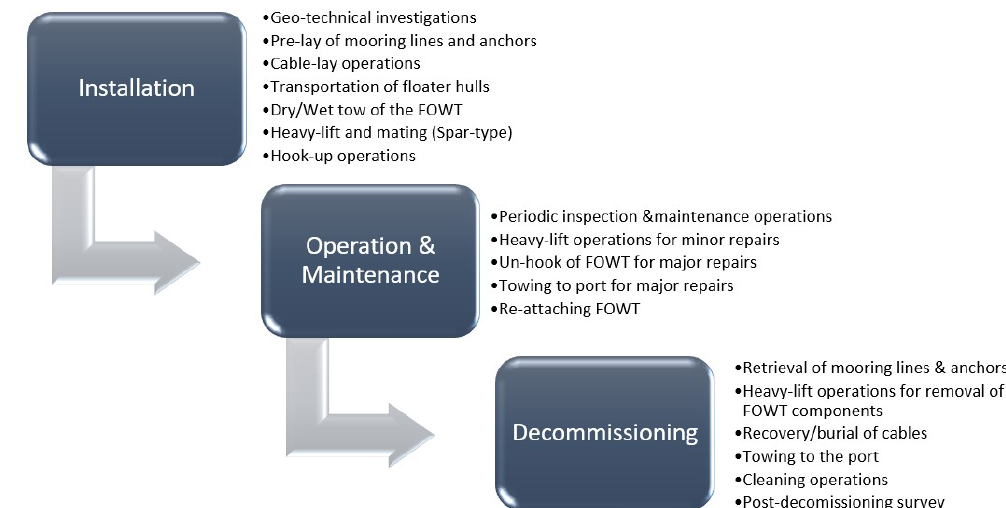
Figure 8. Important factors to be considered for the financial modelling of FOW (floating offshore wind) marine operations (Judge et al., 2019). Table 3. Operability of various vessels used in the FOW domain (Paterson et al., 2018; Ahn et al.,